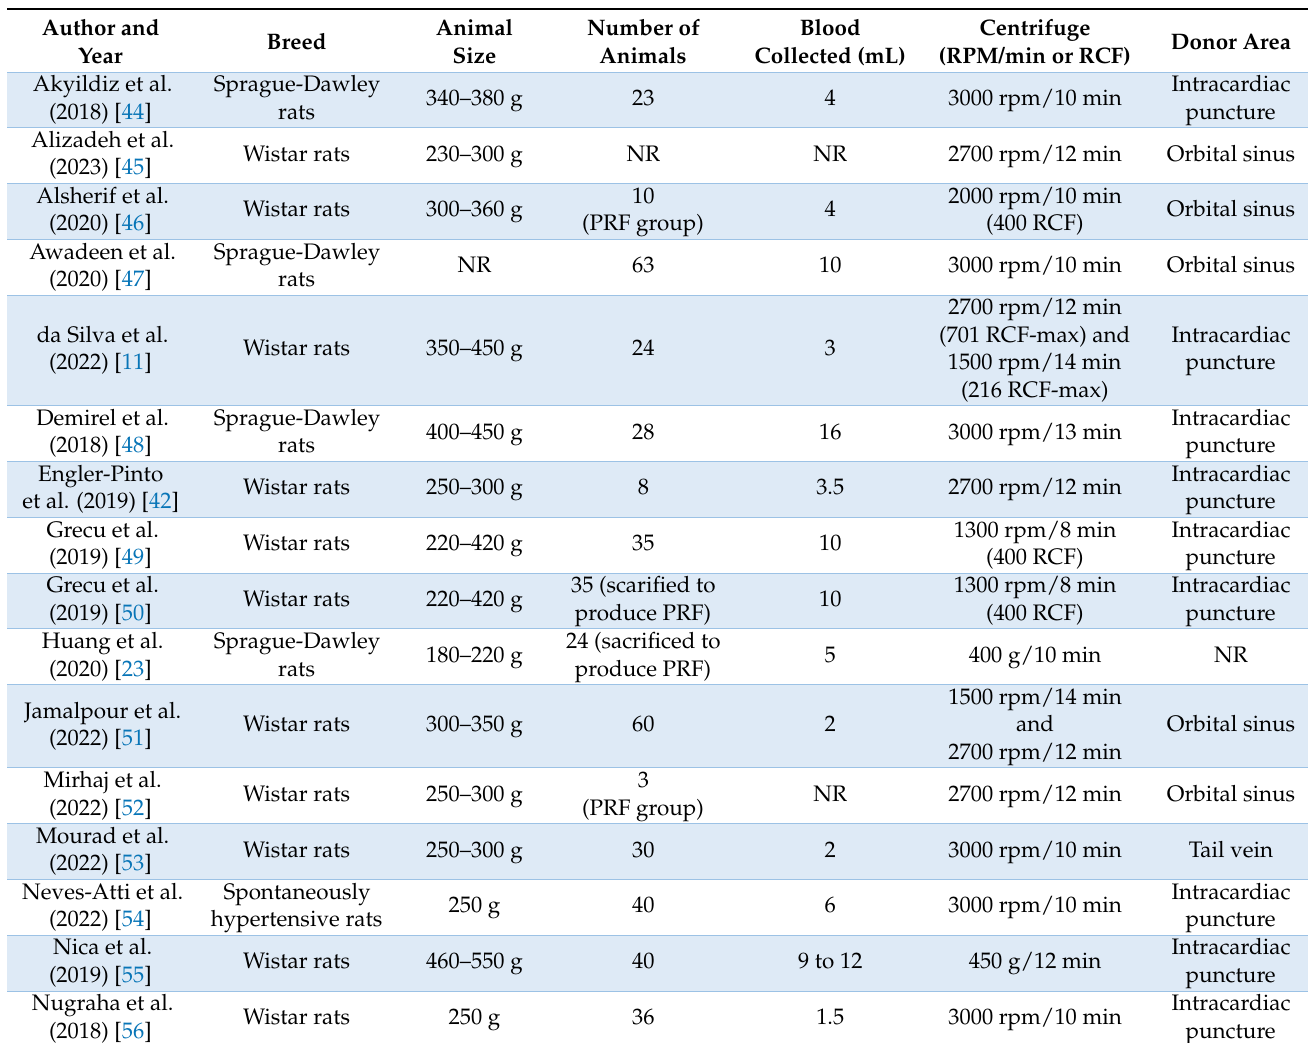
Table 1. Data was collected from the PRF process using the rat model in the last five years, including one from